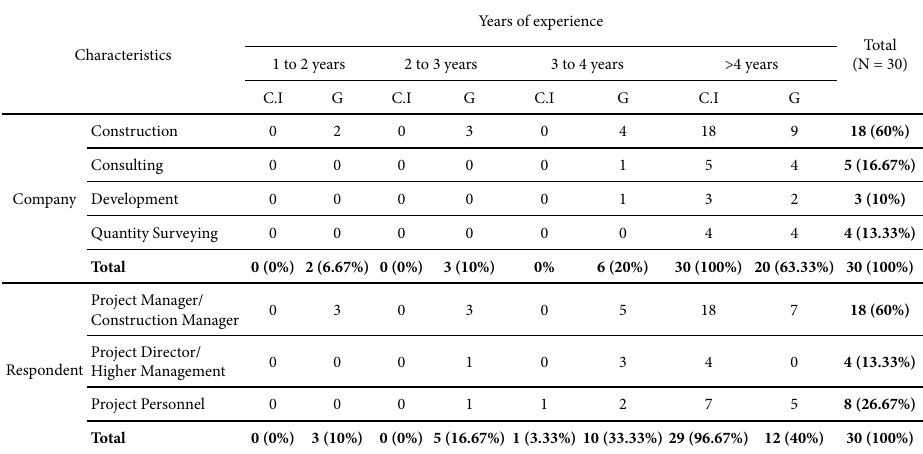
Table 2. Profile of companies and respondents